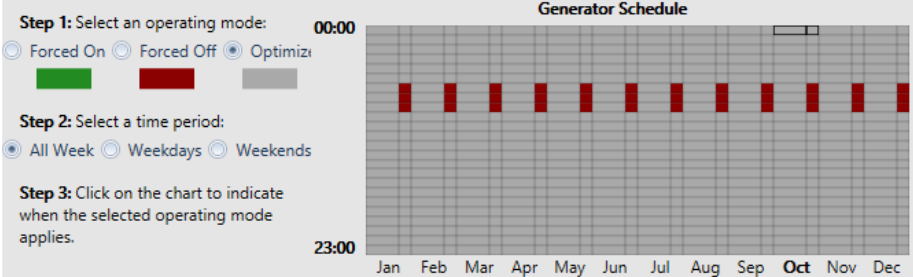
Figure 10. The generator schedule.